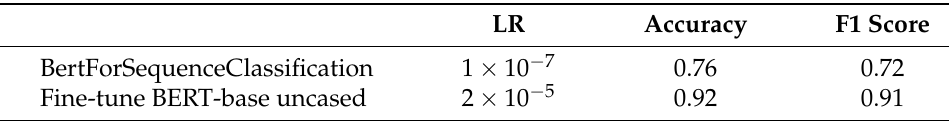
Table 5. Fine-tuning effect on BERT with one classification